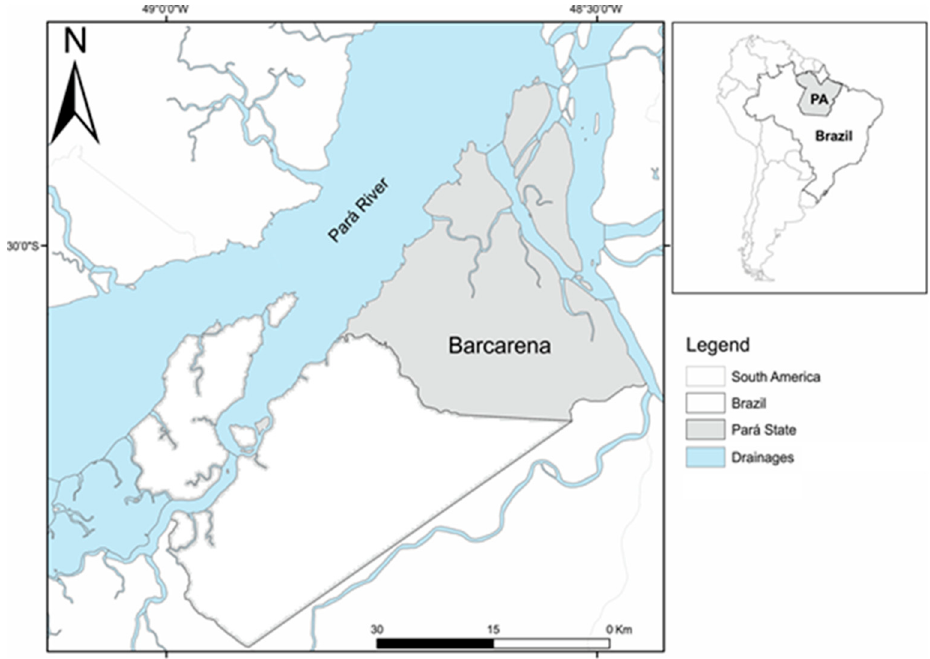
Figure A1. Location of the Dom Manuel (DMN) and the Laranjal (CLA) districts on the map.